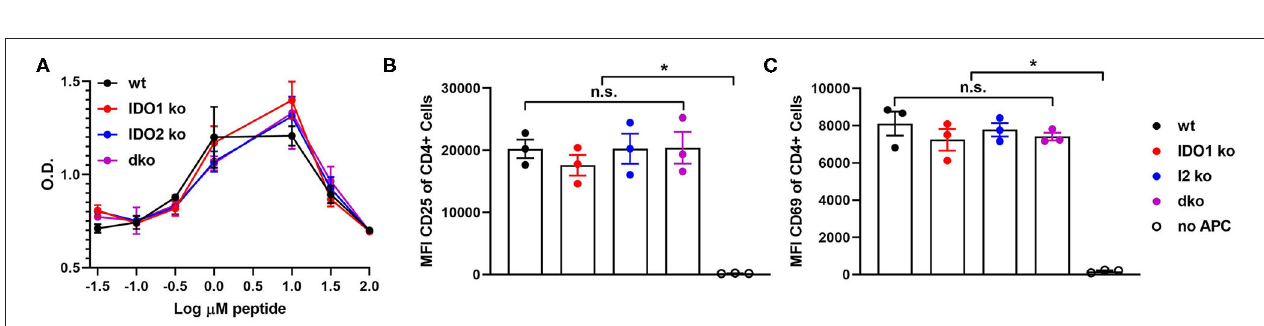
FIGURE 3 | ionomycin + brefeldin A. Intracellular IL-21 was measured by flow cytometry. Symbols represent individual mice and histograms show mean % IL-21 + cells ± SEM out of total CD4 + T cells. N = 32 wt, n = 21 IDO1 ko, n = 18 IDO2 ko, and n = 18 dko KRN.g7 mice, pooled from 9 independent experiments. (C–E) Cells from the joint dLNs were cultured for 24h in PMA + Ionomycin. (C) IL-17a, (D) TNF α , and (E) IFN γ were measured in the supernatants by cytometric bead array. Symbols represent individual mice and histograms show mean concentration ± SEM from n = 33 wt, n = 21 IDO1 ko, n = 21 IDO2 ko, and n = 15 dko KRN.g7 mice, pooled from 9 independent experiments. P -values were calculated by one way-ANOVA followed by comparison of means with Tukey’s post-hoc multiple comparison correction. * p < 0.05, ** p < 0.01, n.s., not significant.